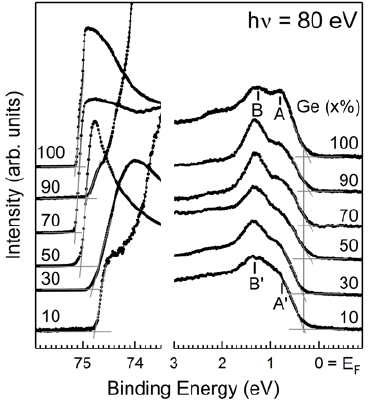
Figure 2. Photoemission data from the molecular beam epitaxy (MBE) as-grown Si 1 − x Ge x (001)-2 × 1 for the valence band spectra and the cutoffs. Symbols A and B stand for the Ge 4p states of Ge(001). Features A’ and B’ both contributed from Si 3p and Ge 4p states of Si 1-x Ge x (001). Table 1. Ionization potential (IP) of Si 1 − x Ge x (001)-2 × 1 grown on Ge(001) and Si(001), with x